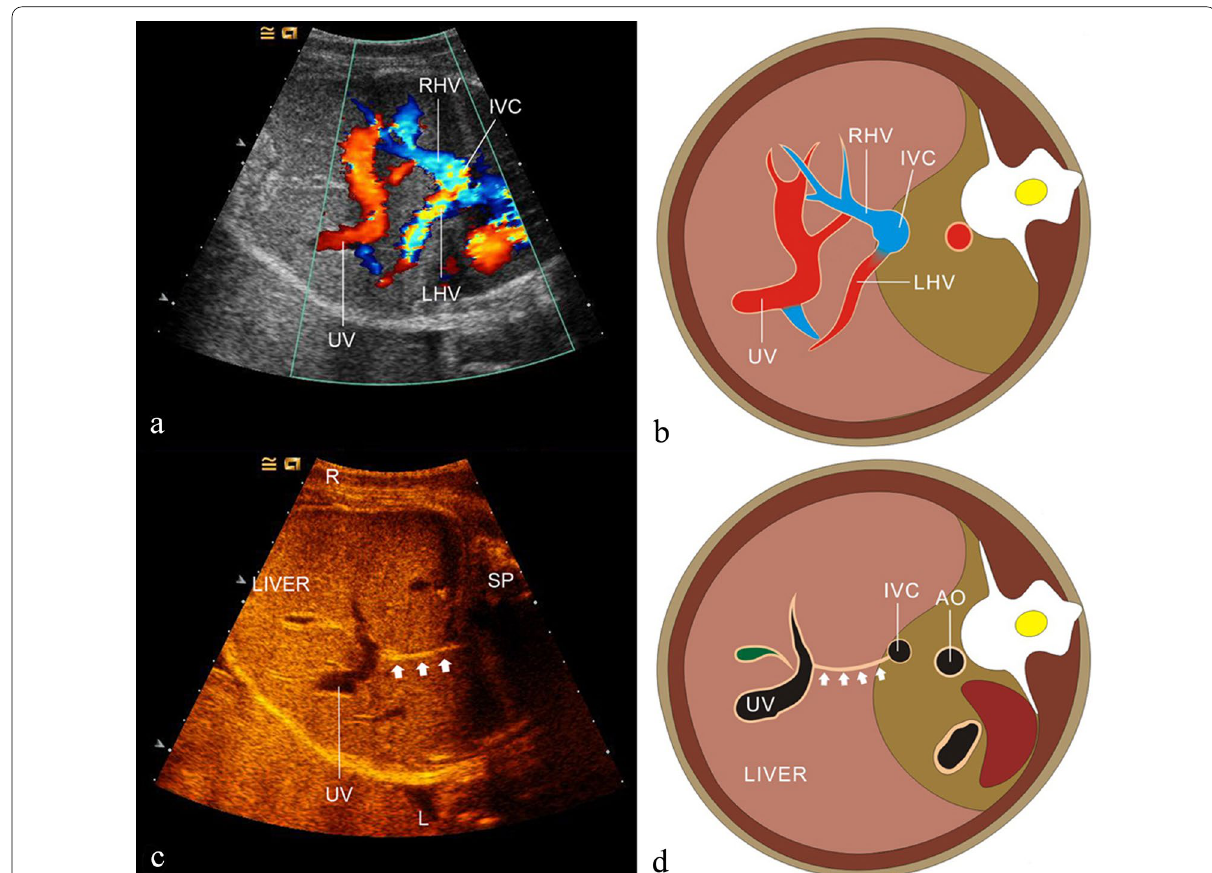
Fig. 18 Sonographic images and schematic drawings illustrate isolated absence ( a , b ) and atresia ( c , d ) of DV